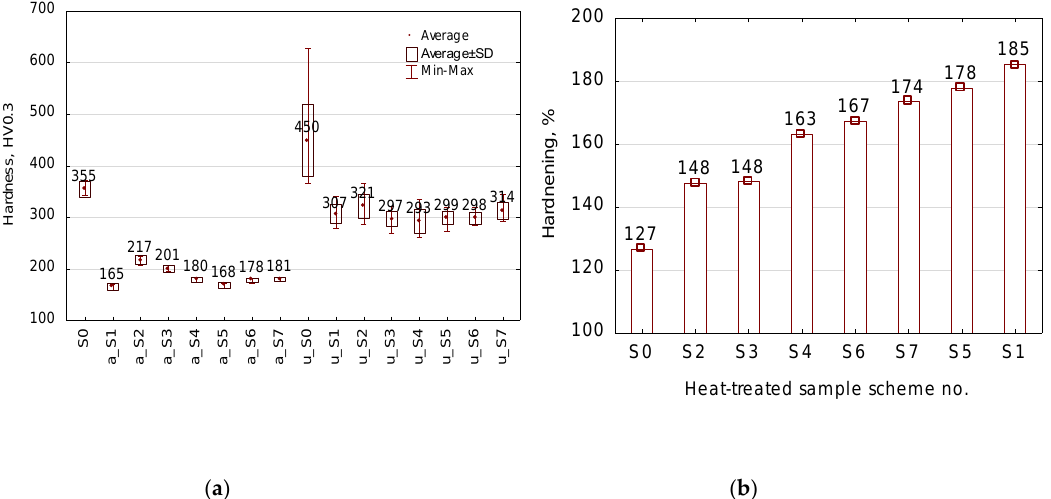
Figure 9. Hardness results of S0–S7 samples: ( a ) microhardness before and after upsetting (marked as “a” and “u”); ( b ) rate of cold hardening due to upsetting.